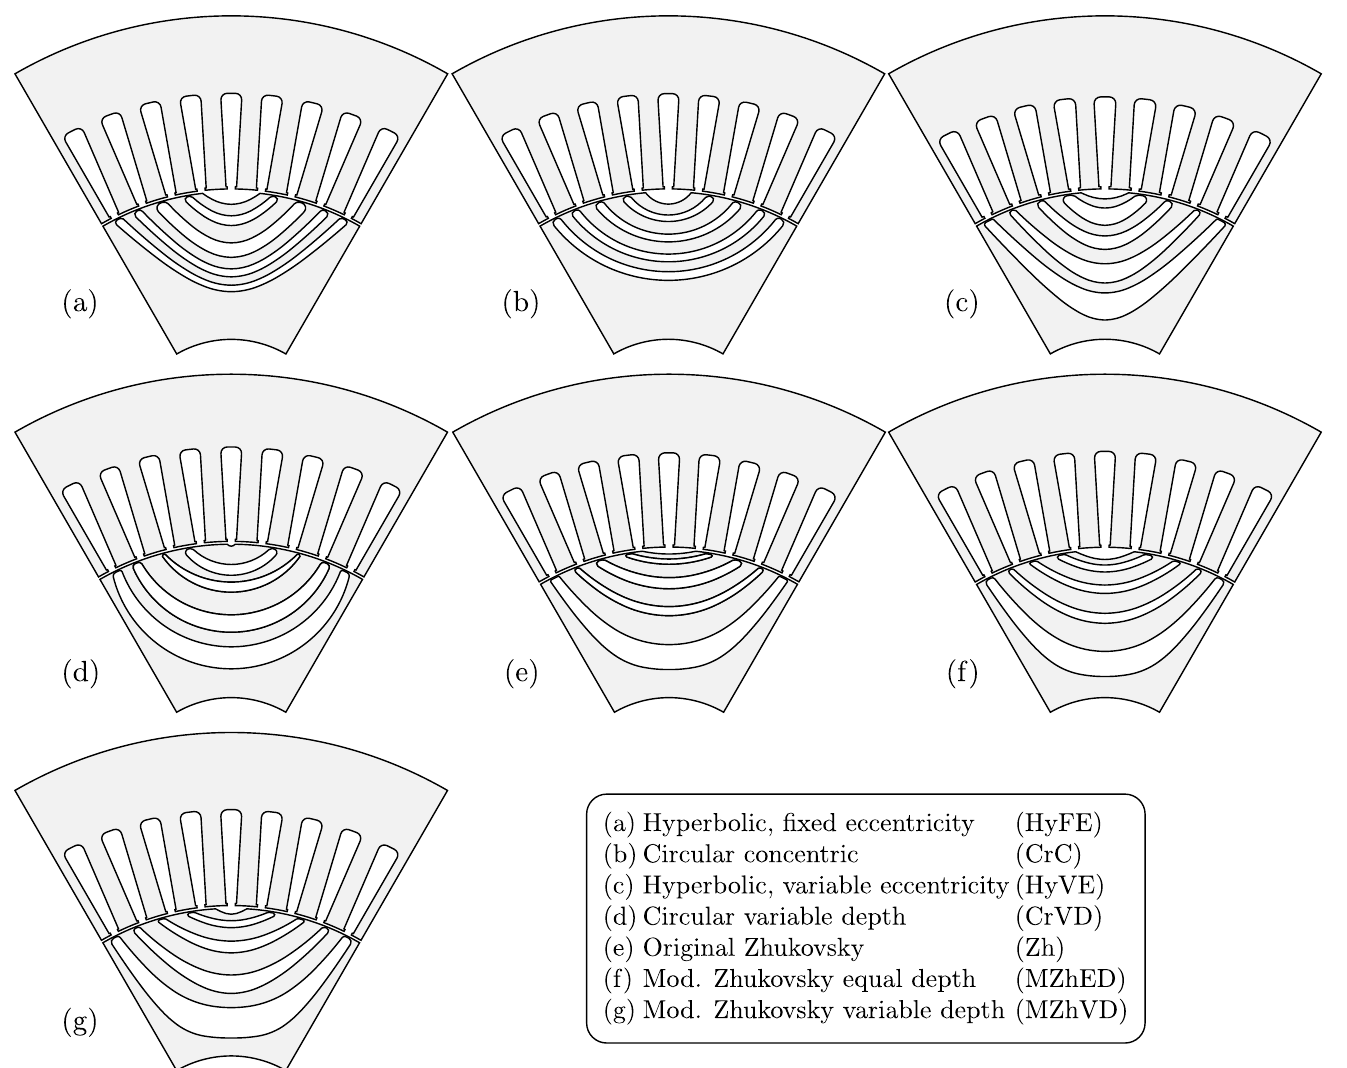
Figure 13. Optimized cross sections per